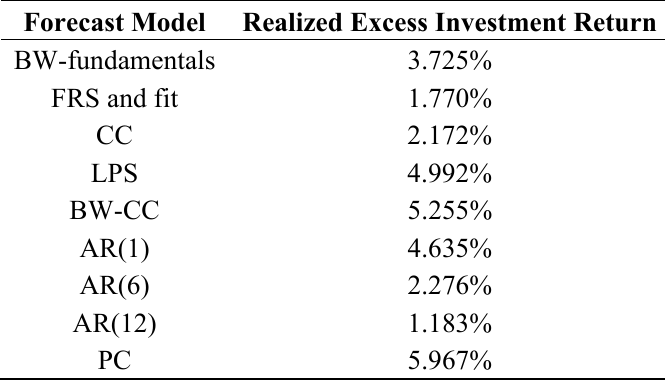
Table A1. Additional models’ forecasting